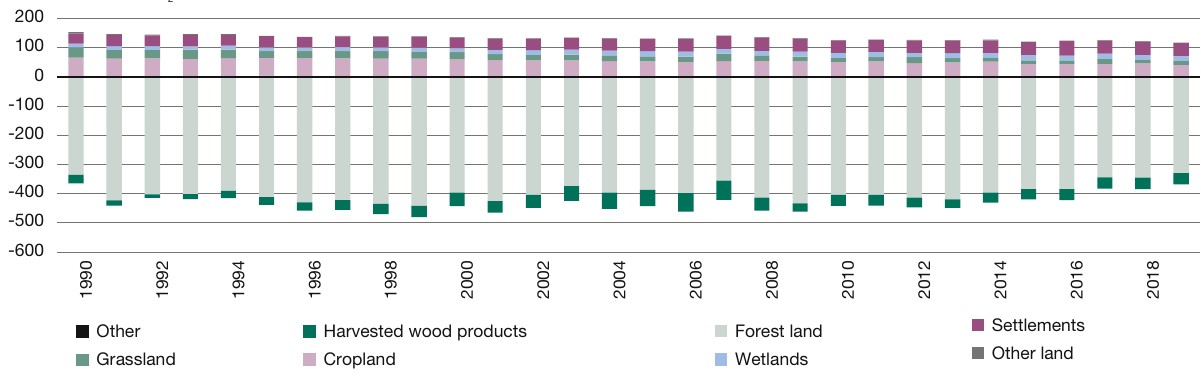
Source: European Environmental Agency